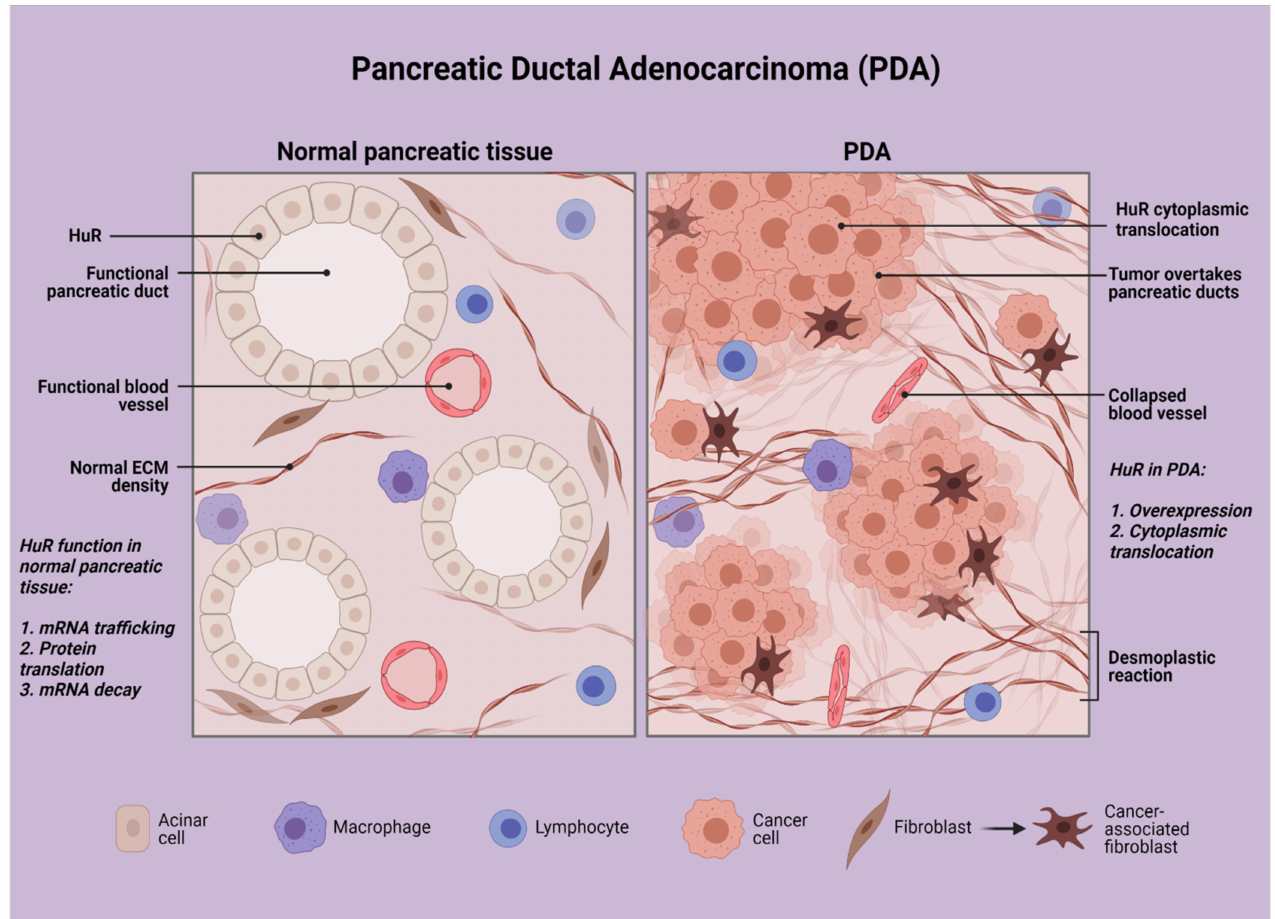
Figure 1. Schematic representation of pancreatic ductal adenocarcinoma in contrast with normal pancreatic tissue. Created with